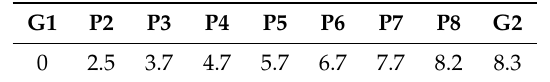
Table 1. Distance (m) from upstream gate (G1) to pressure measurement taps P2–P8 and downstream gate (G2) in Trajkovic et al. [35]